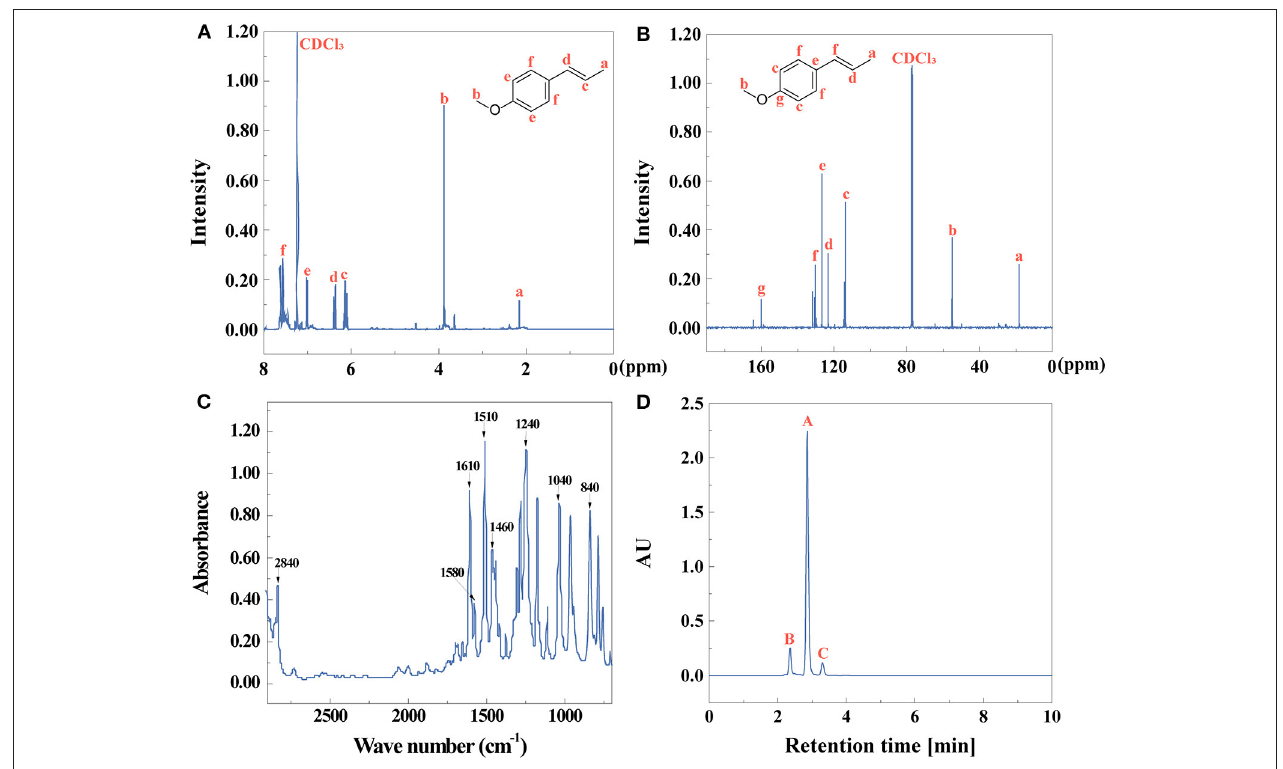
successful extraction of anisic acid by KMnO 4 oxidation was confirmed by 1 H NMR and 13 C NMR spectra ( Figures 2A,B